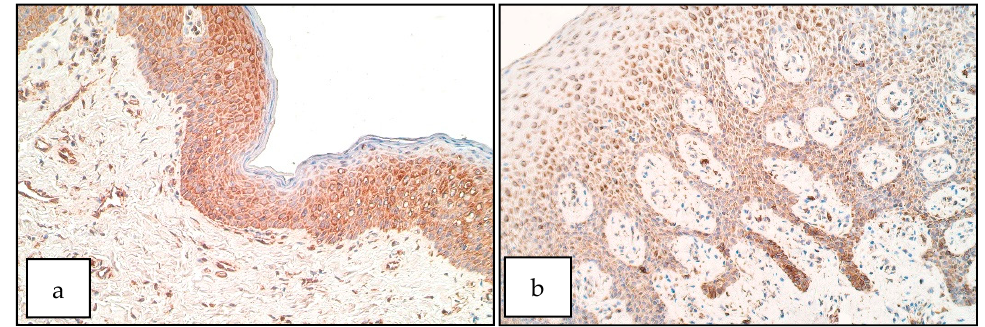
Figure 4. Immunoreactive structures for SHH. ( a ) Moderate to numerous SHH positive structures in patient epithelium, SHH IMH, 200×. ( b ) Moderate SHH positive structures in control epithelium, SHH IMH, 200×.